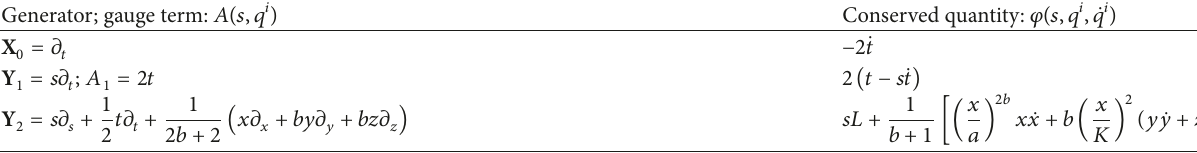
Table 32: Conserved quantities corresponding to each Noether symmetry.